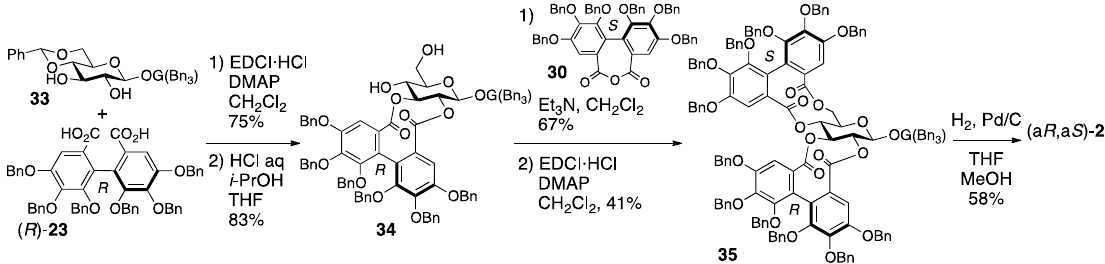
Figure 17. The synthesis of cuspinin ((a R , a S )- 2 ), the structure of which was the revised structure of roxbin B.